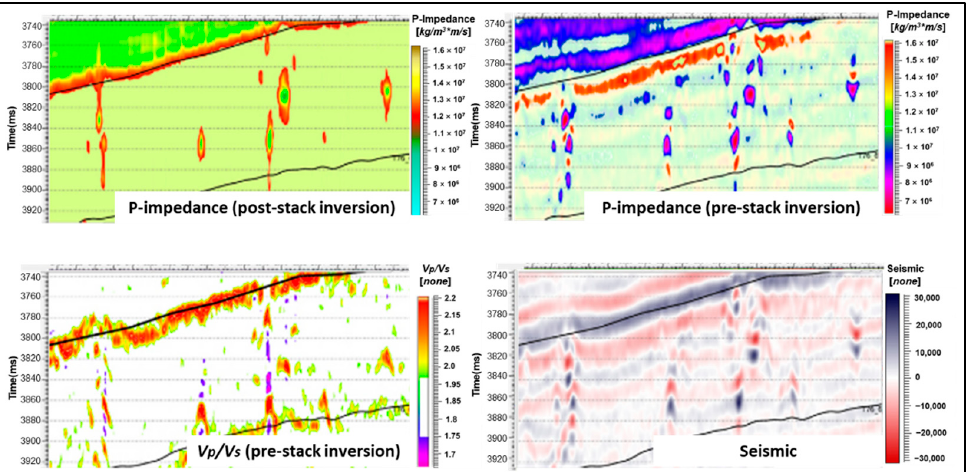
Figure 11. Comparison of P wave impedance profile between post-stack inversion and pre-stack inversion.